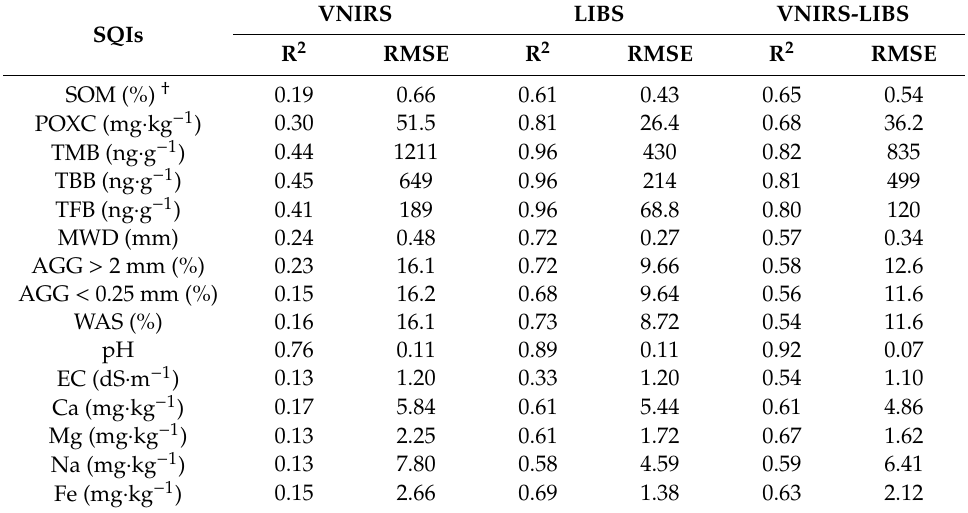
Table 4. Calibration R 2 and root mean square error (RMSE) values of soil quality indicators (SQIs) using visible-near infrared spectroscopy (VNIRS), laser-induced breakdown spectroscopy (LIBS), and combined VNIRS-LIBS for all samples (n =